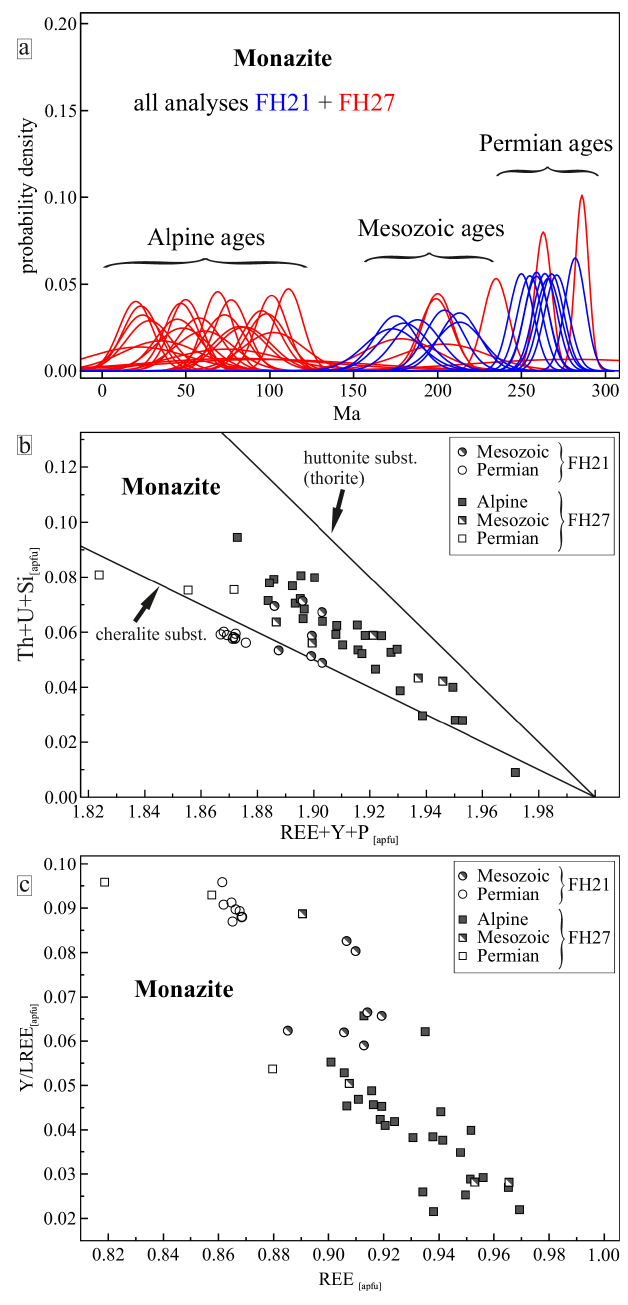
Figure 6. (a) Age distribution diagram for monazite from both FH21 and FH27. (b) Substitution diagram showing the composition of monazite from the two coronae. The two lines represent two sub- stitutions towards the endmembers cheralite: Ca + (Th,U) = 2REE and huttonite: Si + (Th,U) = REE + P. (c) REE composition of